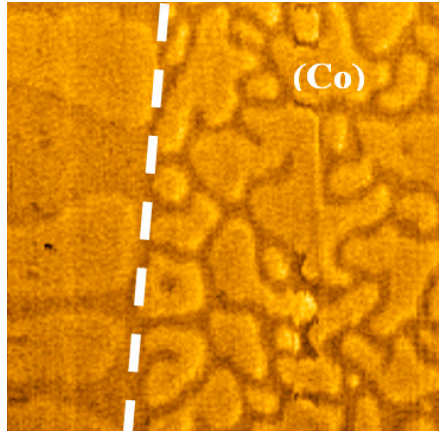
Figure 2. The MFM image of domain structure in demagnetized state of Co/Pt-Co (1 nm) sample near the edge of Co (1 nm) capping layer (Co capping layer is on the right side). The border between Co/Pt and Co/Pt-Co structures is shown by a dashed line. The MFM frame size is 4 μ m × 4 μ m. The MFM contrast is normalized to the maximum.